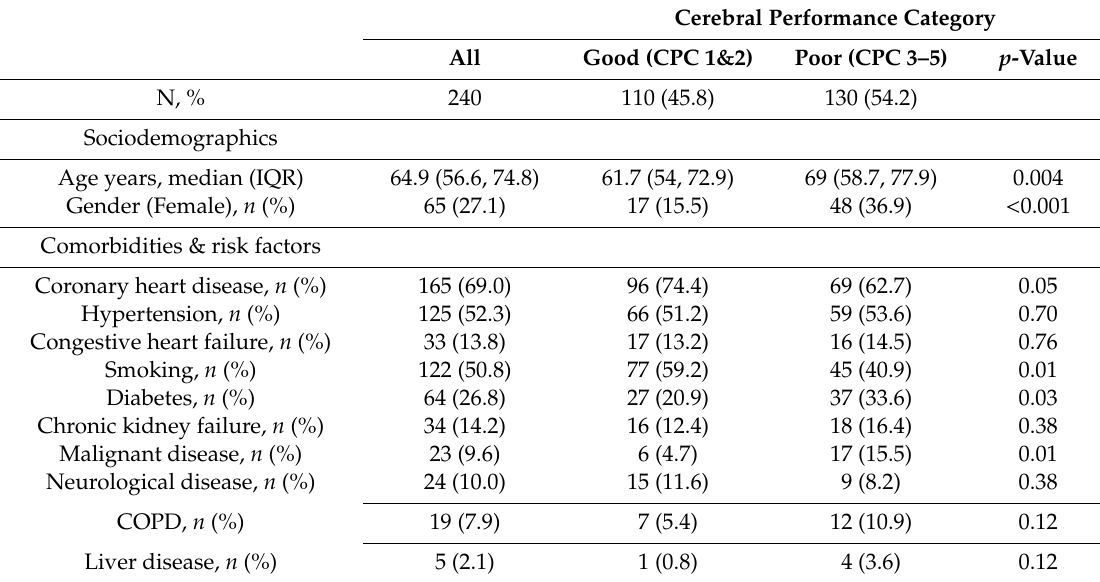
Table A1. Baseline characteristics of the neurological